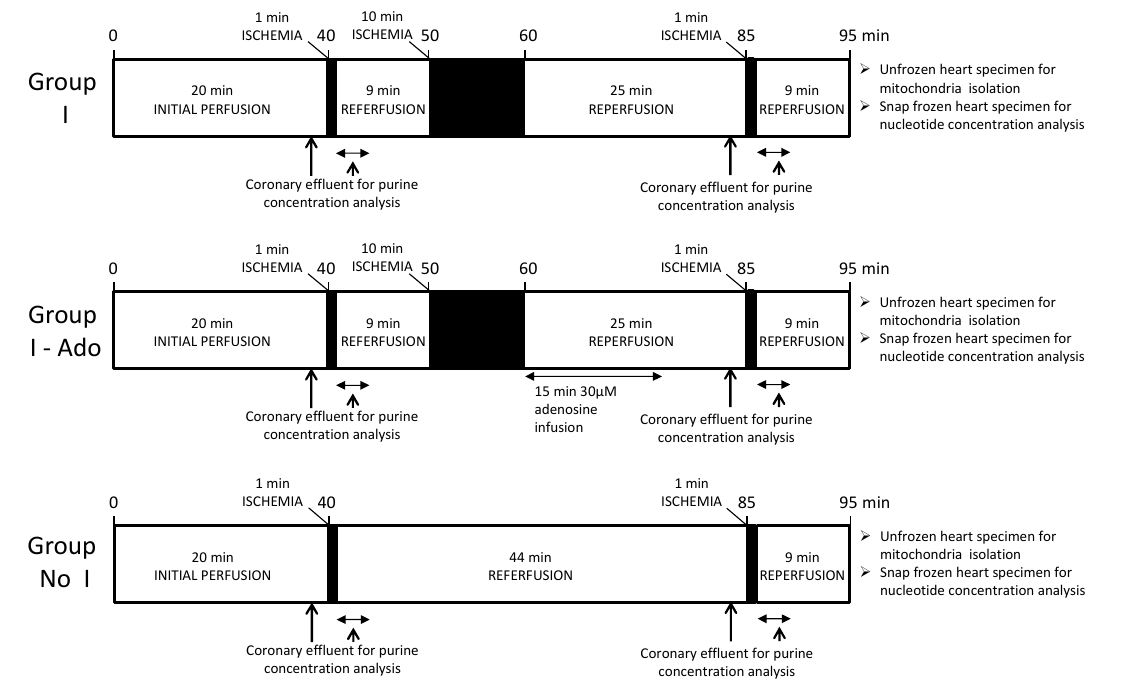
Figure 7. Experimental protocol.